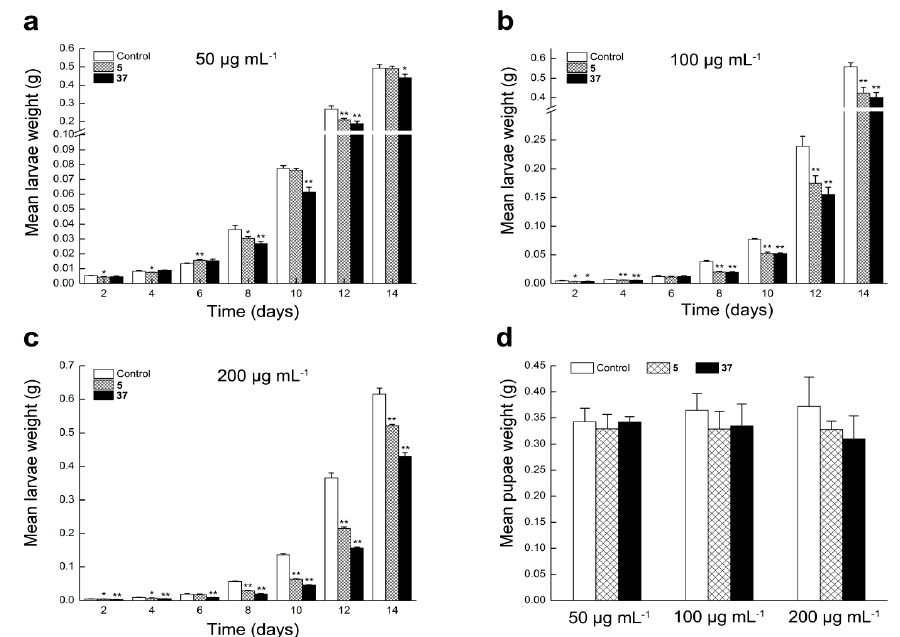
Figure 5. The growth inhibitory activity of compounds 5 and 37 against S. litura . ( a – c ) Mean larvae weight of S. Litura after treatment with 5 and 37 for two weeks at the concentrations of 50, 100 and 200 μ g mL − 1 , respectively. ( d ) Mean pupae weight of S. Litura after treatment with 5 and 37 at the concentrations of 50, 100 and 200 μ g mL − 1 , respectively. Note: (*) p < 0.05 and (**) p < 0.01 in comparison to the control.